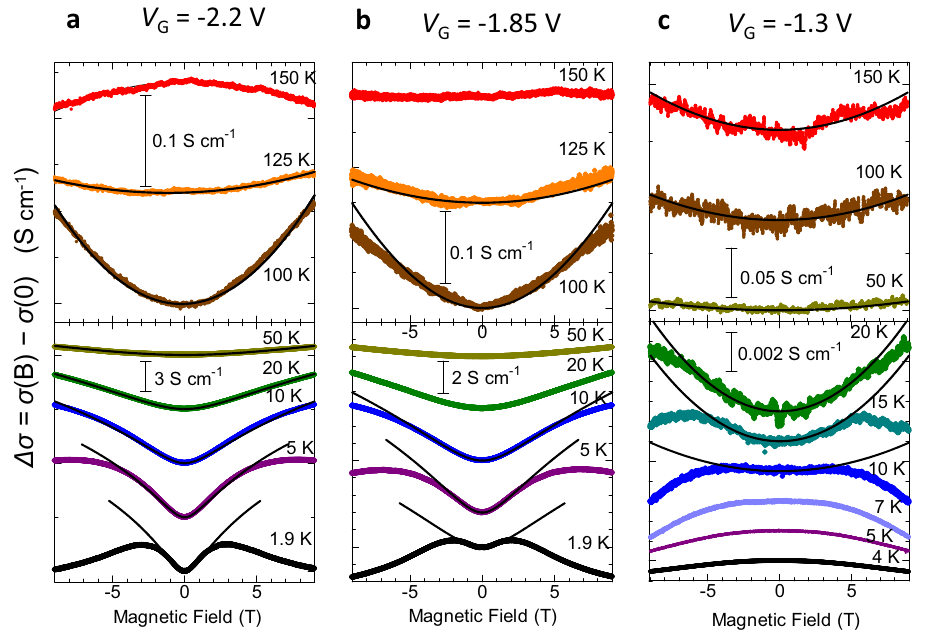
Fig. 3 Temperature and gate voltage dependence of the magnetoconductivity. The magnetoconductivity Δ σ = σ ( B ) − σ (0) under a magnetic fi eld applied perpendicular to the substrate observed at gate voltages a V G = − 2.2 V, b V G = − 1.85 V, and c V G = − 1.3 V. The solid curves represent fi ts based on the Hikami – Larkin – Nagaoka